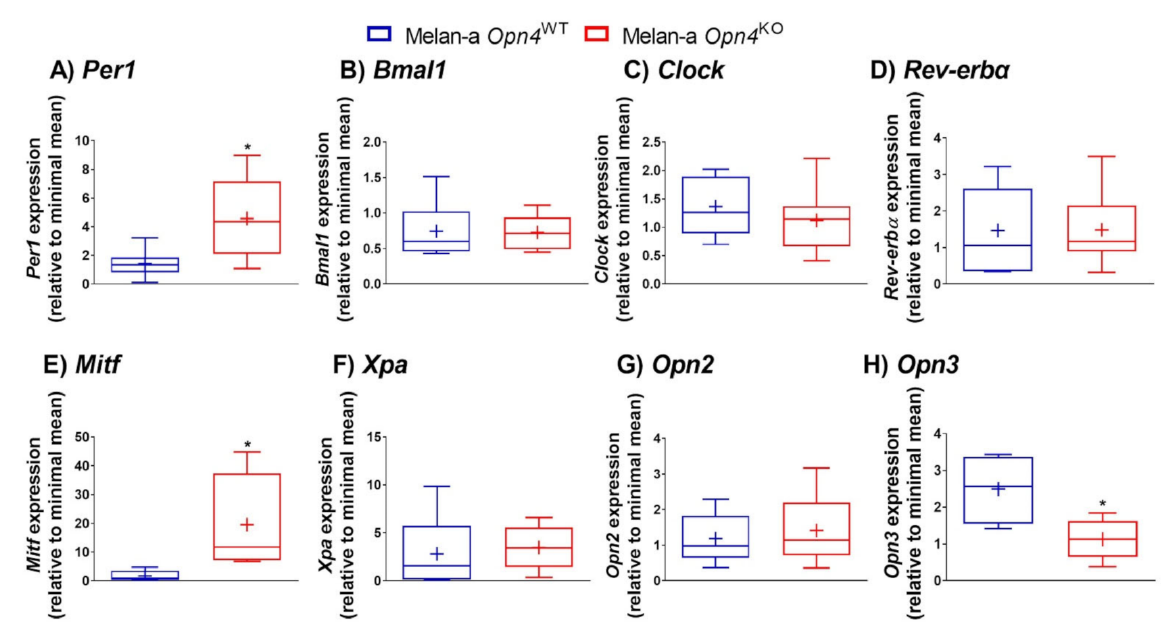
Figure 4. Gene expression of clock genes ( A – D ), Mitf ( E ), Xpa ( F ), Opn2 ( G ), and Opn3 ( H ) in Opn4 WT and Opn4 KO melanocytes. ( n = 4–8). * p <